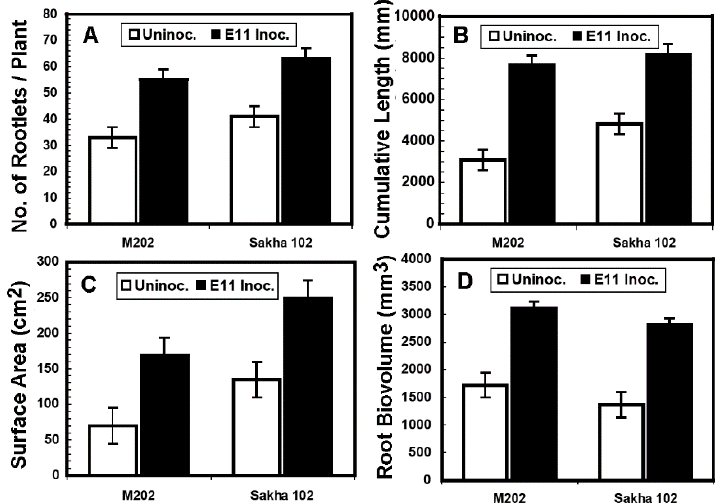
Figure 1. Effects of inoculation with Rhizobium leguminosarum bv. trifolii E11 on the root architecture of two rice varieties (M202 and Sakha 102): ( a ) rootlets per plant; ( b ) cumulative root length (mm); ( c ) surface area (cm 2 ); and ( d ) root biovolume (mm 3 ) [24]. Reproduced from Yanni et al. [24], with permission from CSIRO